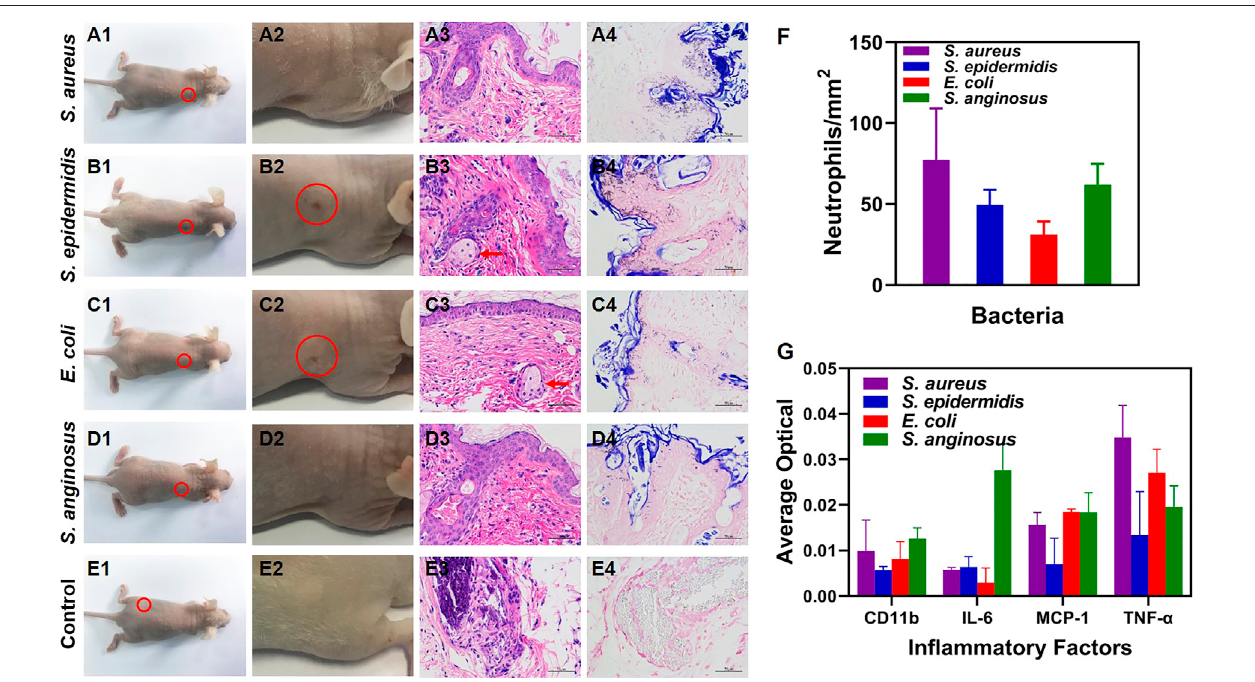
FIGURE 4 | (A1 – E1) Bright- fi eld photographs of the infected nude mice at 3 w post-infection ( E1 is re-used image of A1 in which PBS injected site is circled). (A2 – E2) Corresponding zoomed-in photographs of (A1 – E1) at the site infected with 10 12 CFU/ml of bacteria and the control group (red circle: healed skin rupture). (A3 – E3) H&Estainingmicrographsoftheskintissues atthesiteinfectedwith10 12 CFU/mlofbacteria(redarrow: foreignbodygiant cells; × 400magni fi cation). (A4 – E4) Gram staining micrographs of the skin tissues at the site infected with 10 12 CFU/ml of bacteria ( × 400 magni fi cation). (F) Neutrophil count with the H&E staining micrographs. (G) In fl ammatory factors (CD11b, IL-6, MCP-1 and TNF- α ) measured with immunohistochemical